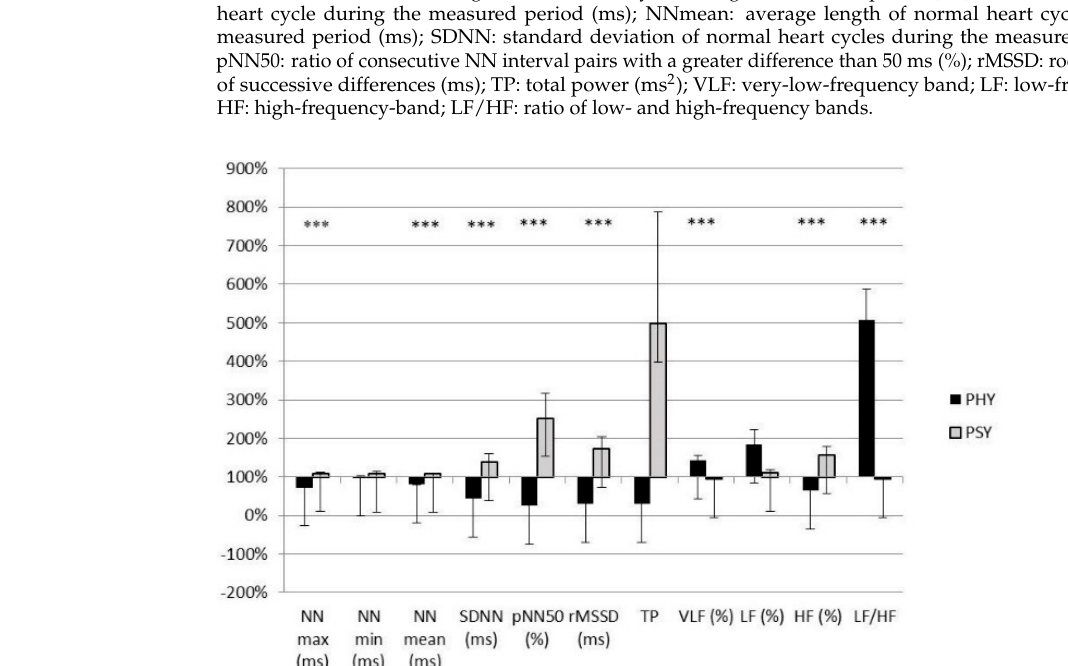
Figure 1. The different trends of HRV parameters between the physical (PHY) and psychological (PSY) stress tests (mean ± standard error of mean; ***: p < 0.001). The measurement of changes is expressed in percentages on the vertical axis. Abbreviations: see Table 1.